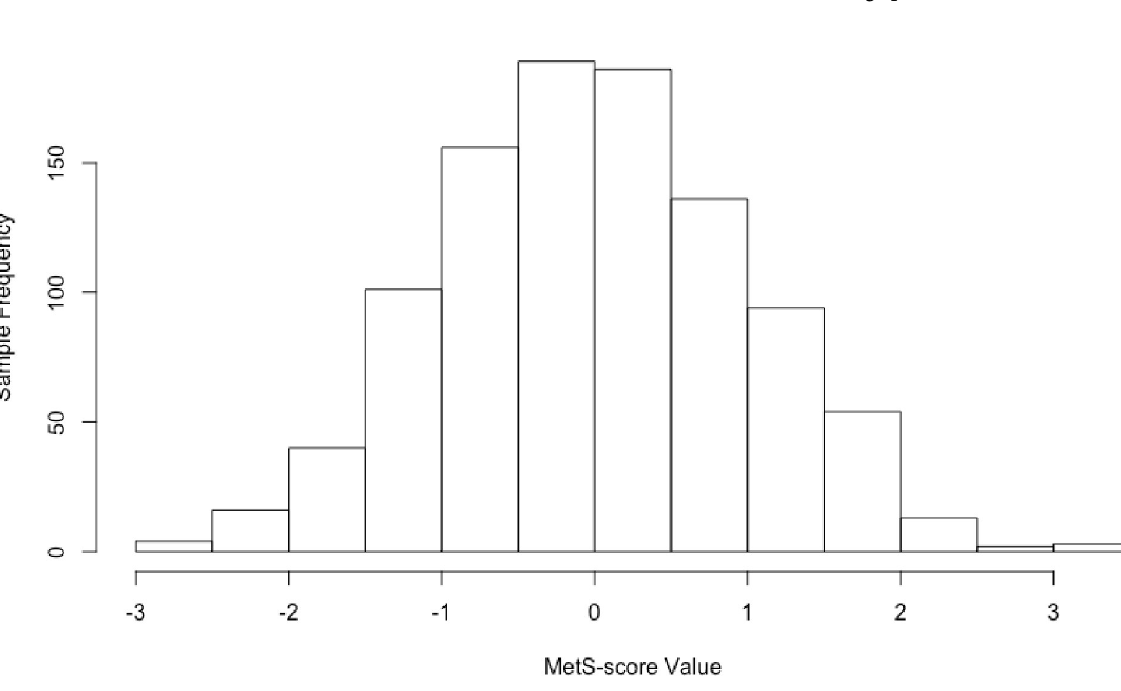
Fig 1. GOLDN MetS-score distribution, N =